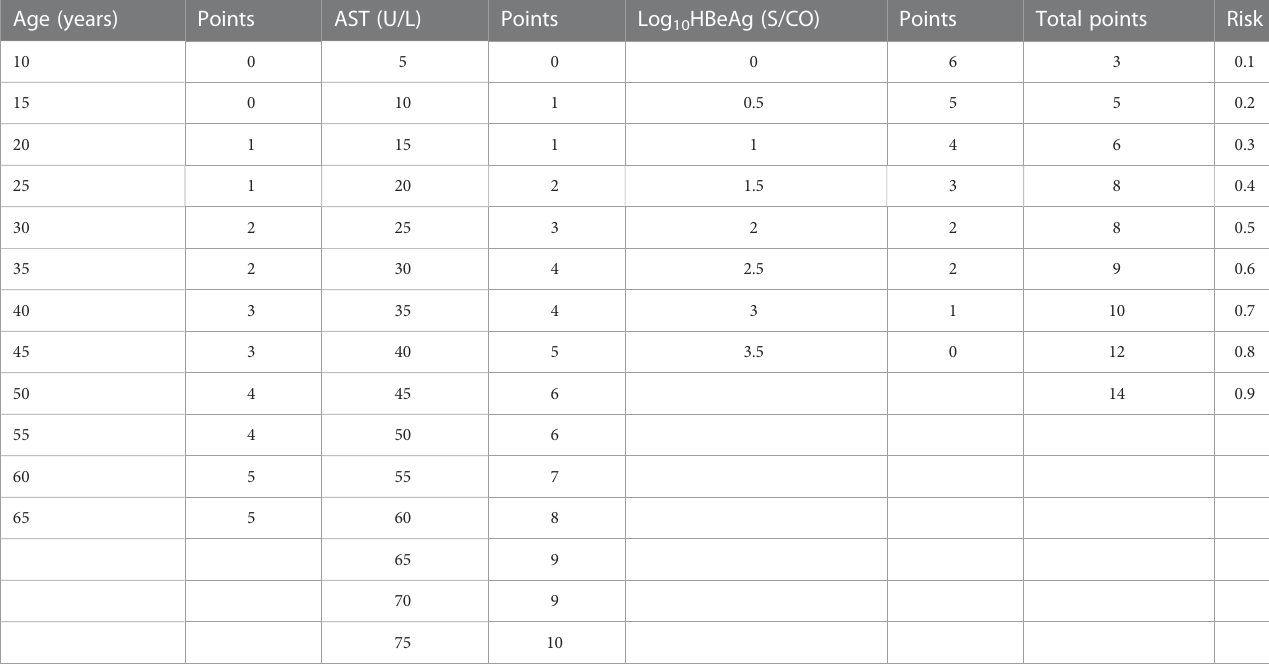
TABLE 4 Point assignment for the nomogram and the prognostic probability of non-minimal liver in fl ammation in HBeAg-positive chronic hepatitis B (CHB) patients with ALT < 80